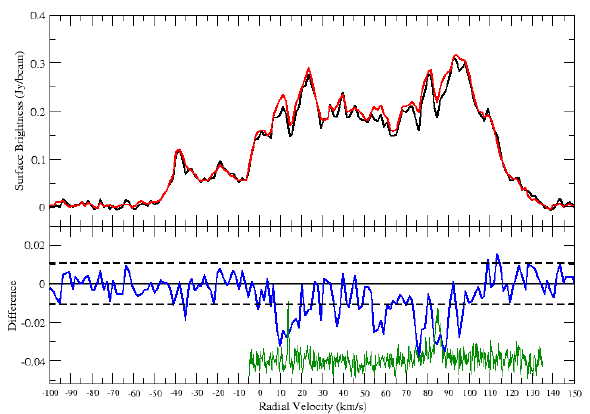
Figure 5. SNR G31.299 − 0.493 ( a ) THOR 1440 MHz continuum image; ( b ) MAGPIS 1.4 GHz image; ( c ) MAGPIS 6 cm image. The green contours are at 10, 30, and 50 mJy/beam from the THOR image. The HI spectrum of G31.299 − 0.493 is shown in Figure 6. Significant HI absorp- tion is detected in the positive velocity range above the ± 2 σ noise level. With the 13 CO emission coinciding with the HI absorption, the SNR is located at the distance corre- sponding to ∼ 85 km s − 1 . The ∼ 85 km s − 1 corresponds to near and far distances of 5.0 and 9.2 kpc, respectively. However, the absorption is seen at < 100 km s − 1 (tangent point v r ∼ 110 km s − 1 ), implying a location at the near kinematic distance of 5.0 ± 0.3 kpc.